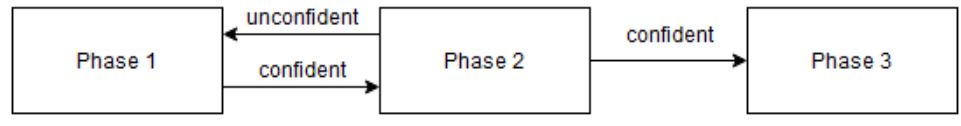
Figure 6. UAV confident-related phase